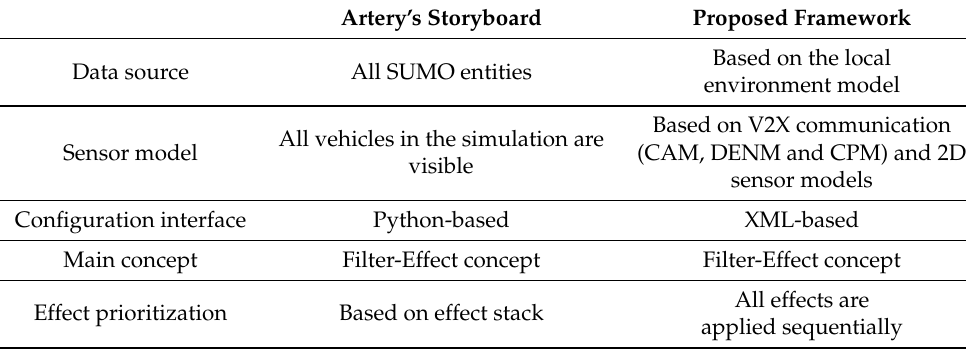
Table 1. Comparison of application simulation frameworks in